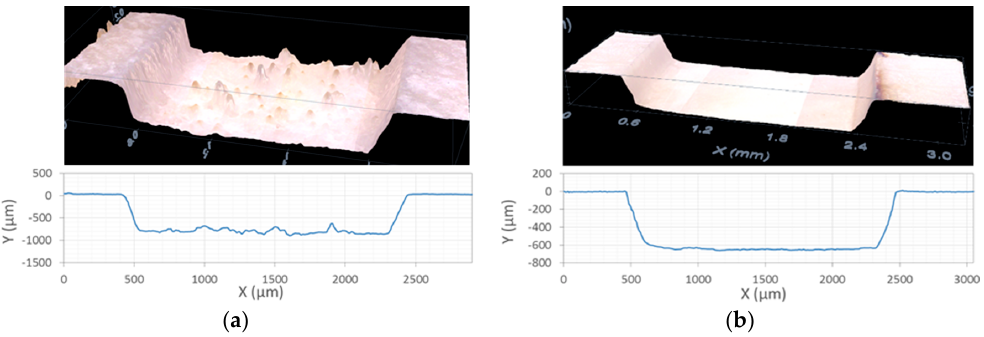
Figure 3. Confocal microscope images and profiles of 2 mm × 2mm squared holes ablated with: ( a ) UV ns laser pulse, with 880 µm deep; ( b ) IR ps laser pulse, with 690 µm deep. The profiles correspond to a line crossing the center of the square. The pulse fluence, process speed, repetition frequency, pitch, and number of cycles used for each sample are, respectively: ( a ) 16.6 J / cm 2 , 50 mm / s, 2 kHz, 50 µ m, 50; ( b ) 11.9 J / cm 2 , 500 mm / s, 100 kHz, 10 µ m,